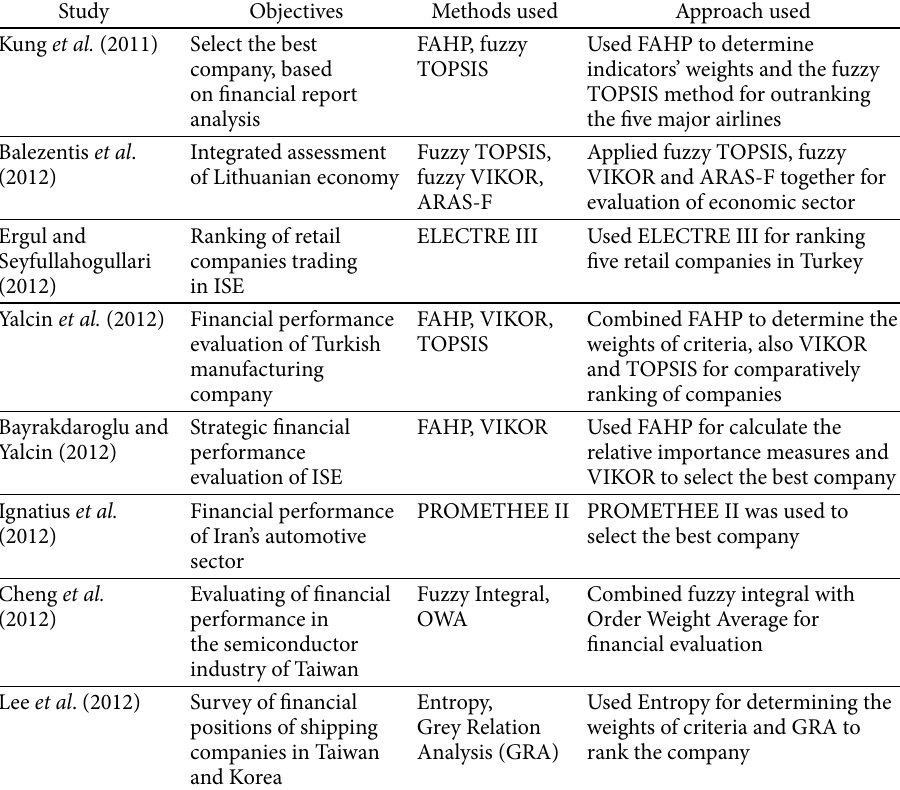
Table 1. Comparison of the previous studies that have used MCDM methods for financial performance